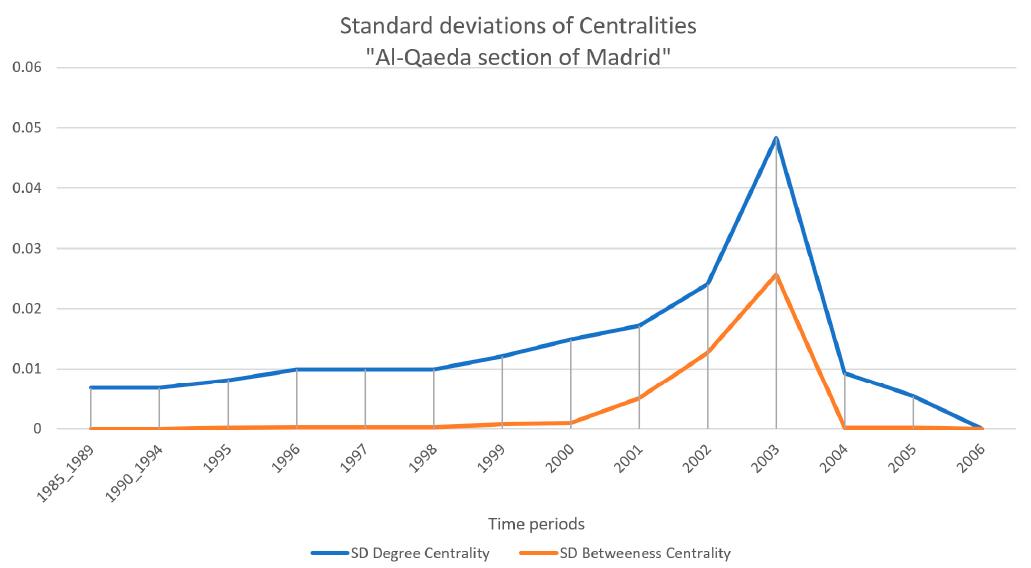
Figure 19. Temporal development of the standard deviation of degree centrality and the standard deviation of betweenness centrality for the “Al-Qaeda section of Madrid”. Both indices increase, reach a maximum in 2003 and then decrease rapidly.